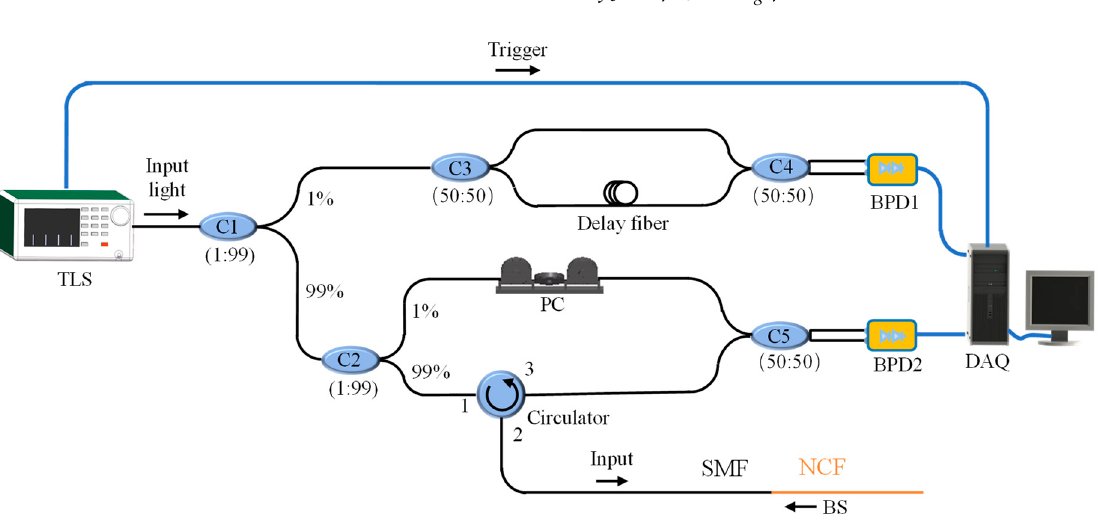
Figure 1. The system schematic of the optical frequency domain reflectometry. TLS: tunable laser source; C1-5: couplers; BPD1-2: balanced photodetectors; PC: polarization controller; DAQ: data acquisition; SMF: single-mode fiber; NCF: no-core fiber; BS: back scattering.